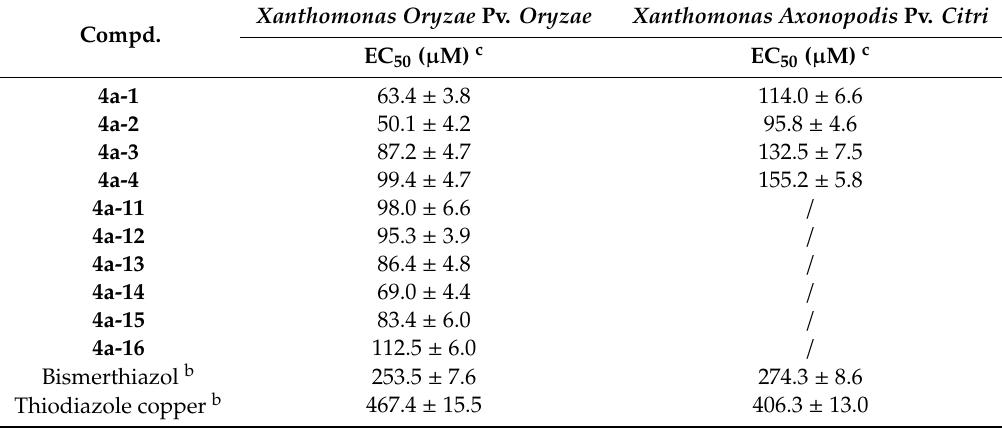
Table 2. EC 50 ( µ M) of some target compounds against Xanthomonas oryzae pv. oryzae and Xanthomonas axonopodis pv. citri a .